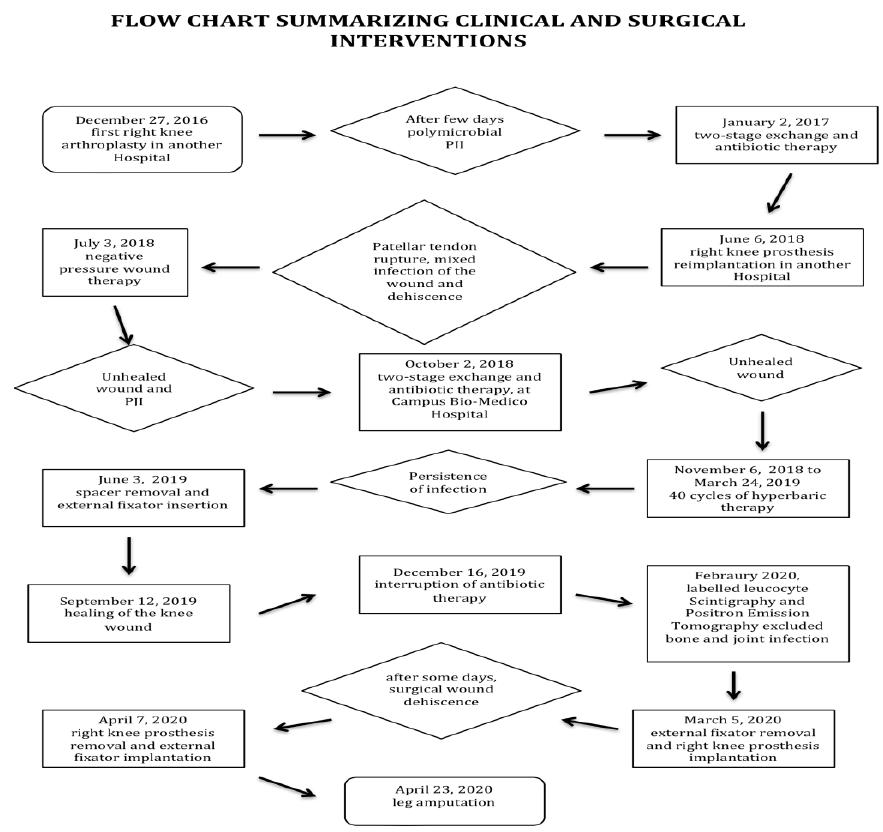
Figure 2. Flow chart summarizing clinical and